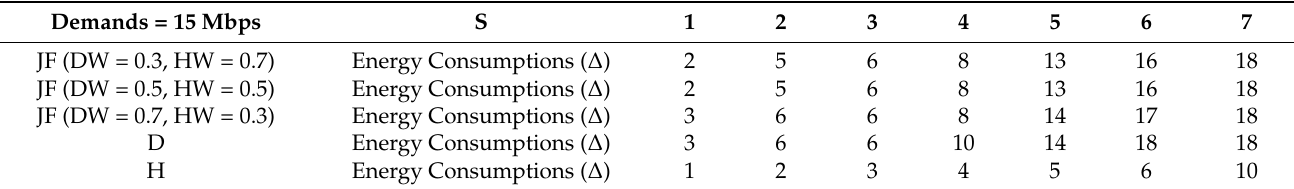
Table 5. Energy consumption of all three algorithms when demand = 15